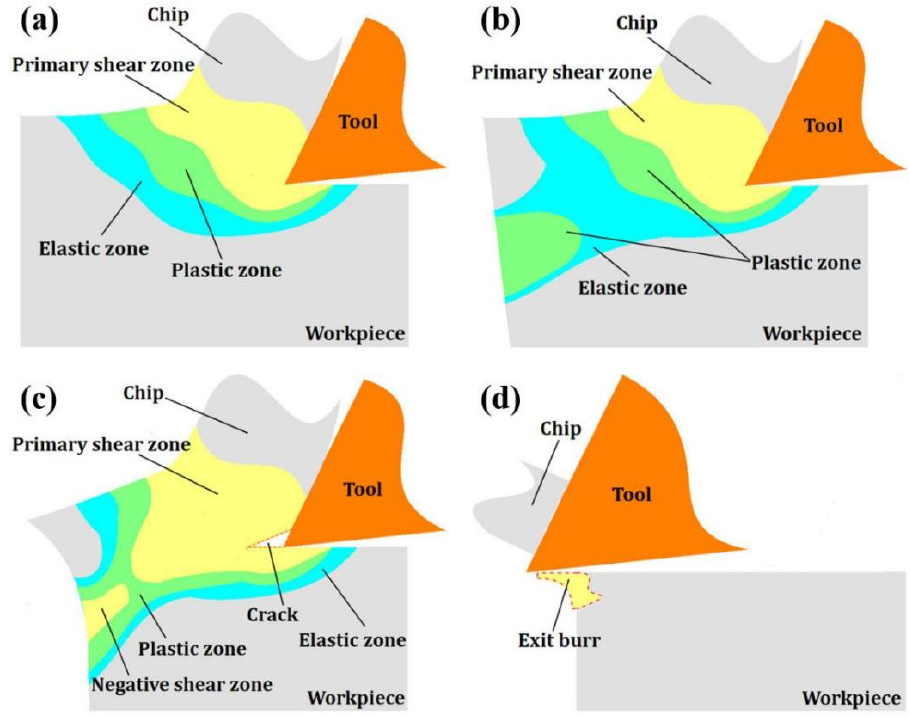
Figure 1. The formation process of the exit burr: ( a ) The stress distribution around tool tip; ( b ) The changes in stress distribution state; ( c ) The generation of crack and negative shear zone; ( d ) The formation of exit burr.